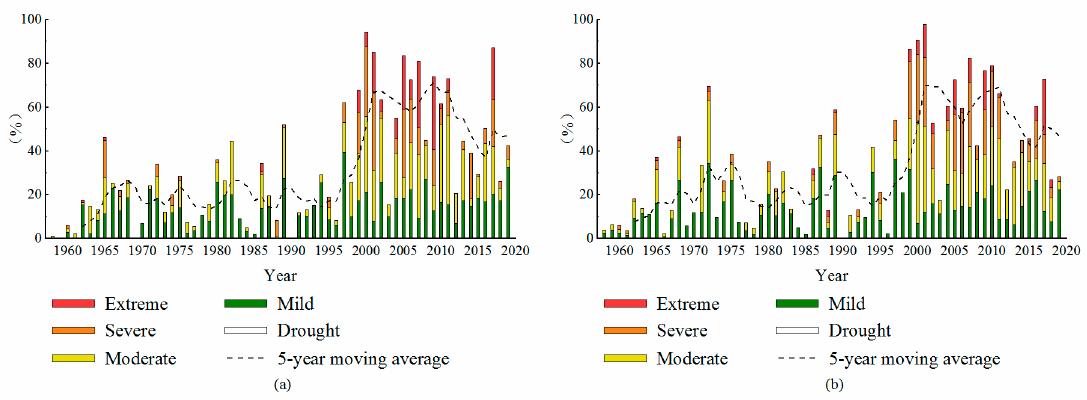
Figure 6. The changes in the proportion of drought area in ( a ) annual and ( b ) plant growth period, over the years.